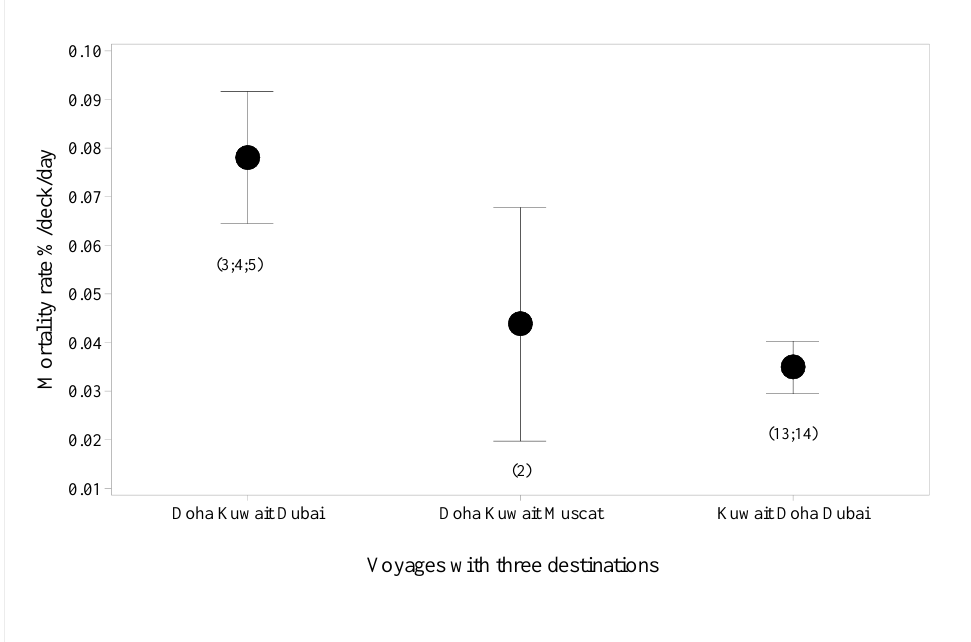
Figure 5. Mortality rate (%/deck/day with standard deviations) for voyages ( n = 12, voyage numbers in parentheses) offloading at different ports.